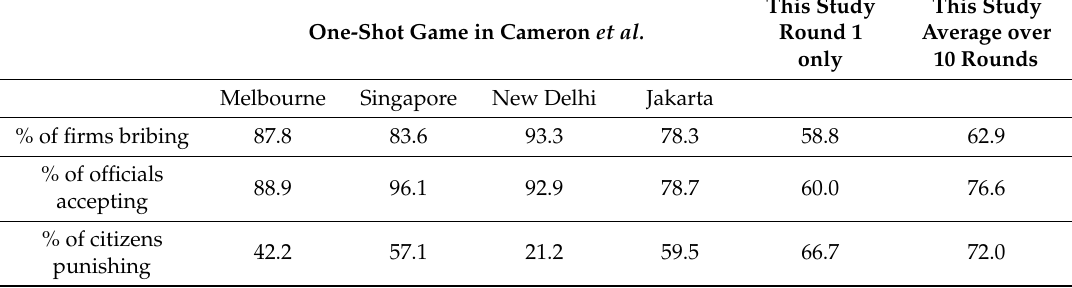
Table 2. Summary of